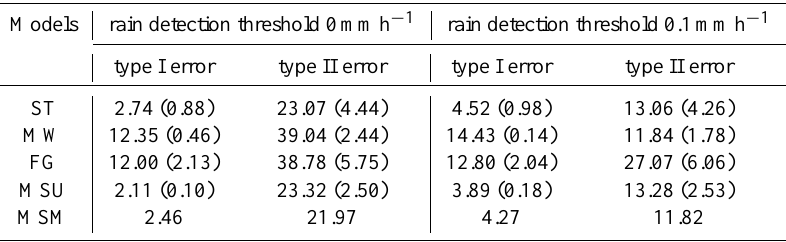
associated standard deviation. Note that no model parameters could be fitted for the MSU algorithm on channel which did not converge for this channel, have been replaced by the